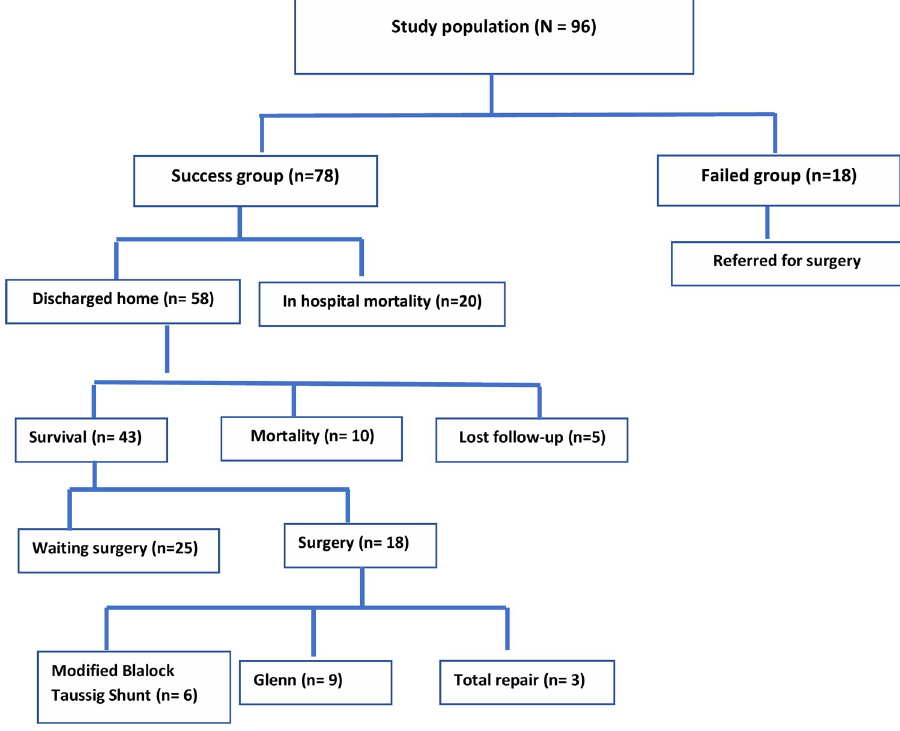
Fig 3. Scheme of the studied